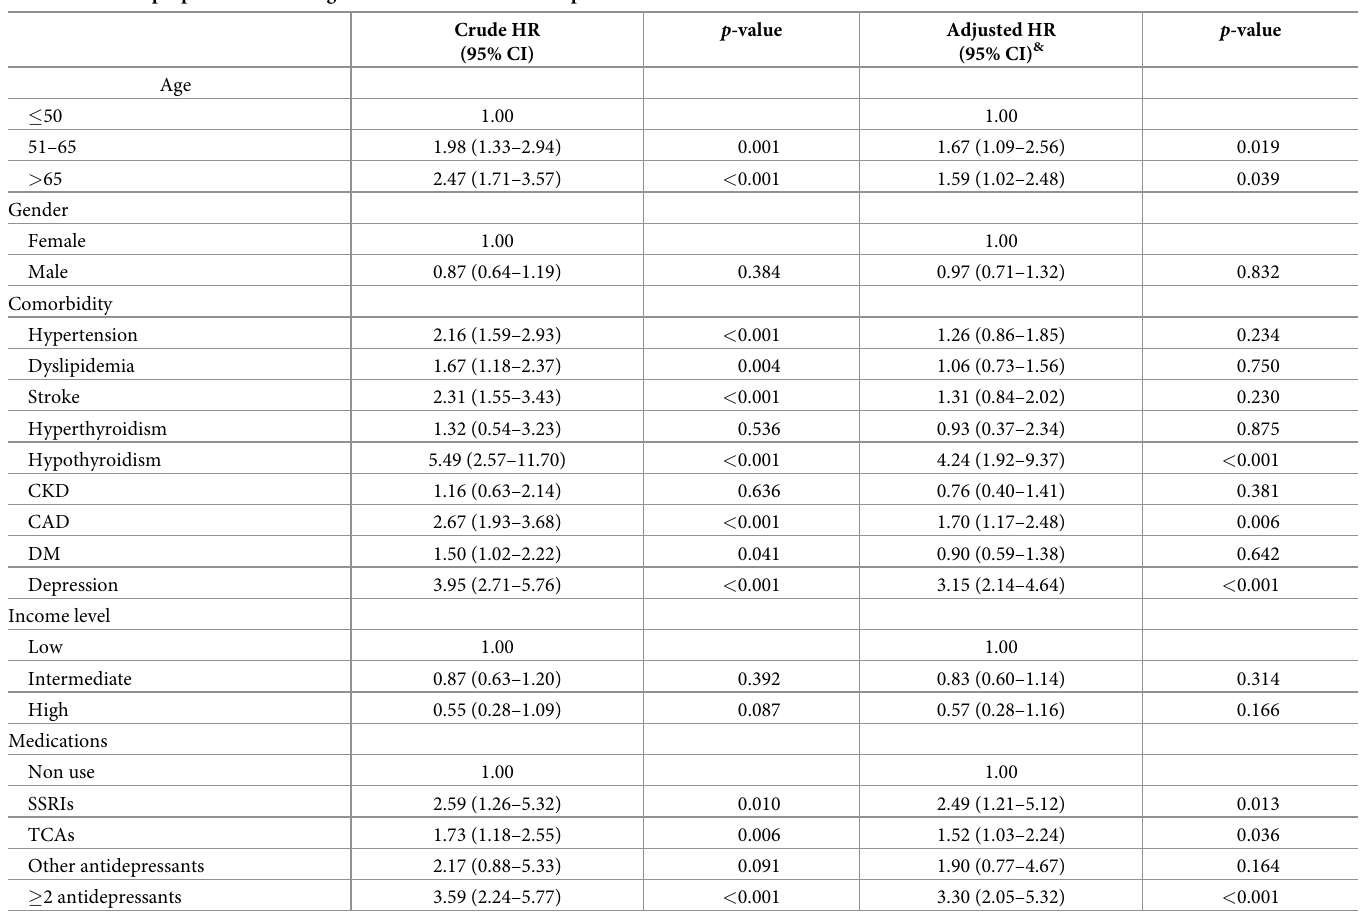
Table 3. The cox proportion hazard regression model of RLS in IBS patients.